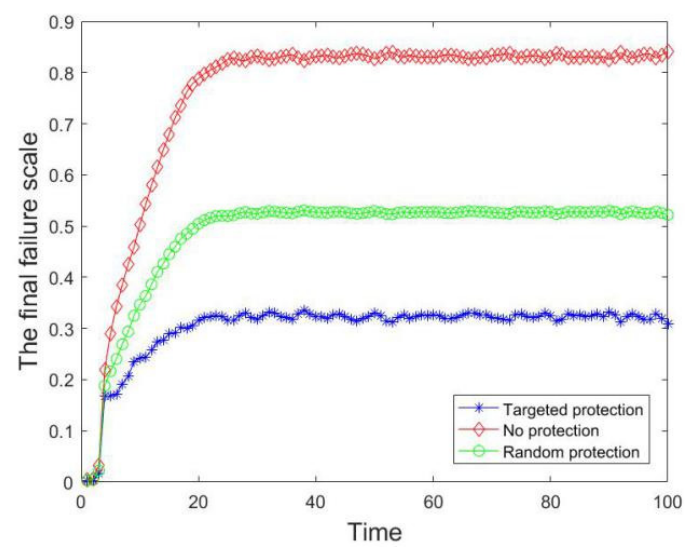
Figure 14. Failure scales under different node protections.